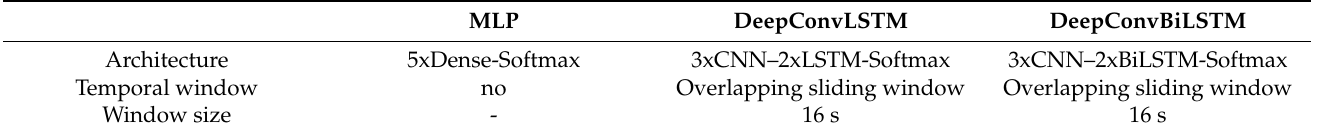
Table 2. Architecture of the DL models used for the parameter study. MLP DeepConvLSTM DeepConvBiLSTM Architecture Temporal